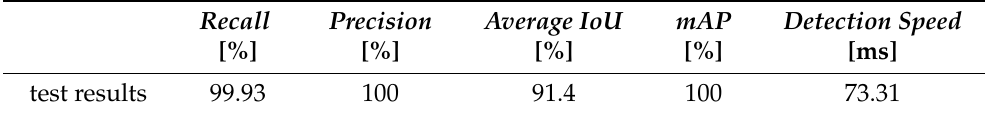
Table 2. Fox detection test results for the trained model.